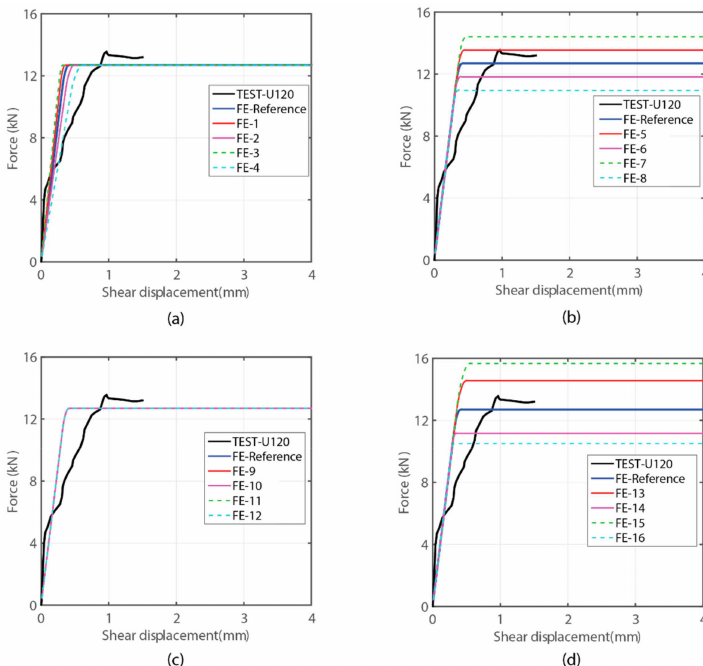
Figure 11. Shear force vs. shear displacement plot for the parametric study with changes in interface material properties: ( a ) sti ff ness ( k sx , k sy ); ( b ) cohesion, c ; ( c ) interface tensile strength, f ti ; ( d ) friction coe ffi cient, tan φ